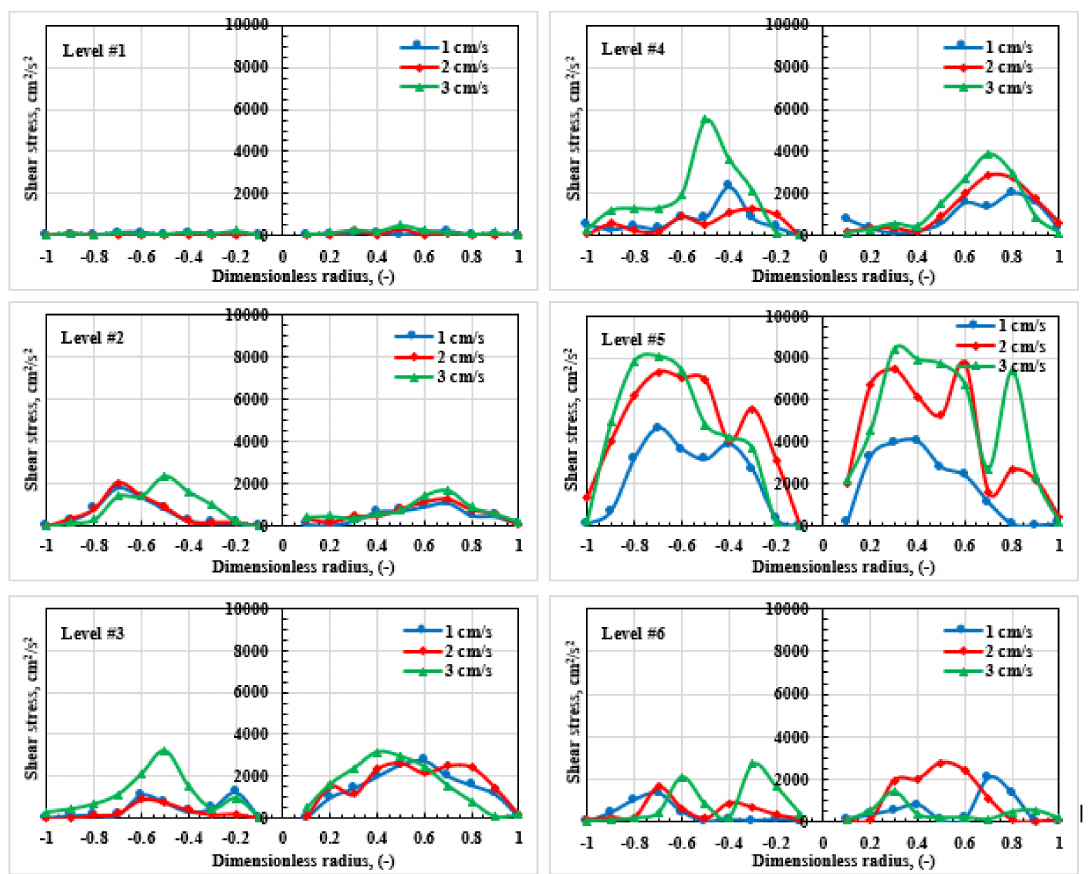
Figure 19. Local Reynolds shear stress profiles at different height of split airlift reactor operated under different gas